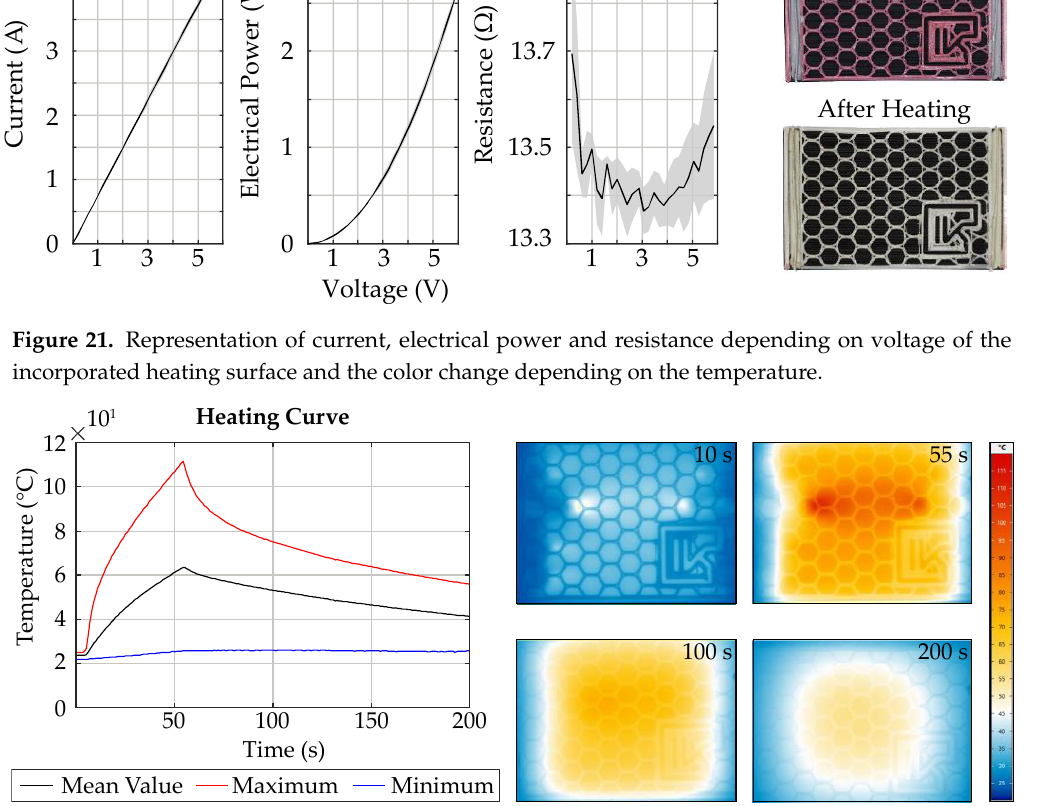
Figure 21. Representation of current, electrical power and resistance depending on voltage of the incorporated heating surface and the color change depending on the temperature.